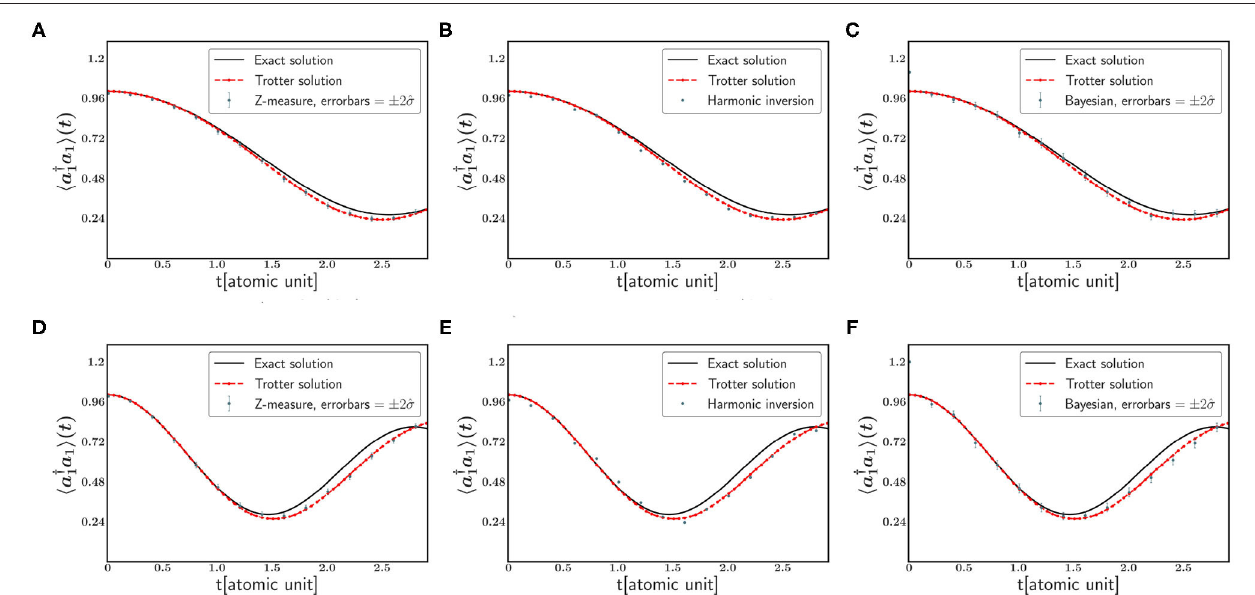
FIGURE 2 | The expectation value of a † 1 a 1 is measured via (A,D) direct Z -basis measurement, (B,E) harmonic inversion, and (C,F) Bayesian inference. The upper panel are the results of 4-orbital model, the lower panel are the results of the 8-orbital model. All of the data points are plotted against the exact Trotter solution depicted in as a continuous line. In (C,F) , the first point shows a large deviation from the Trotter solution typical of the behavior of Bayesian inference whenever the exact density’s value is close to one. Error bars shown in (A,C,D,F) are two standard deviations about the mean. The harmonic inversion does not have error bars because the error comes from two sources: from the sampling error at different time τ and from the reconstruction of the density using harmonic